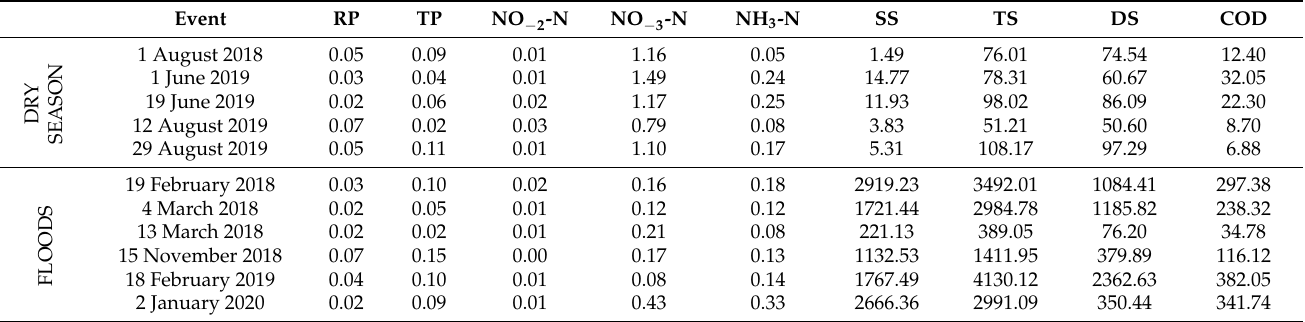
Table 3. EMC estimates for each event at VP River in